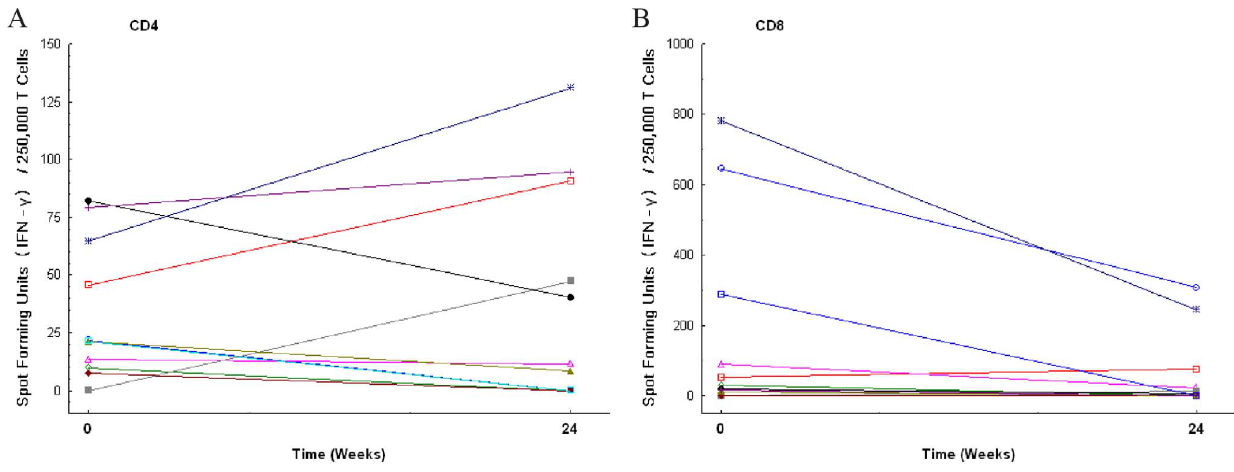
Figure 4. Mycobacteriumtuberculosis (Mtb) specific T cell responses during antituberculosis treatment in subjects with baseline malnutrition (BMI # 17). The subgroup of subjects, who started therapy with a BMI # 17 with baseline and week 24 analyzable ELISPOT data (n=11) are shown. The magnitude of the Mtb specific T cell response is shown by IFN- c ELISPOT to ESAT-6 and CFP-10 and reported in spot forming units per 250,000 T cells. Connected lines at baseline and week 24 reflect a individual subject’s profile for the Mtb specific CD4 + T cell response (A) and the Mtb specific CD8 + T cell response (B).